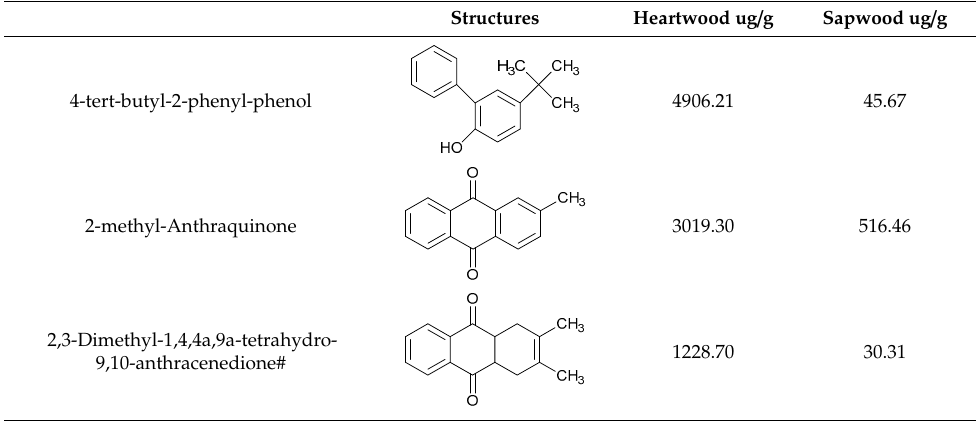
Figure 3. Contents of various compounds in acetone extractives in the heartwood and sapwood of teak. Table 6. The compounds in the heartwood and sapwood of teak with obvious difference in content. Structures